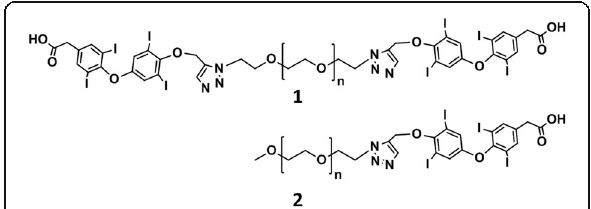
Fig. 1 Chemical structures of P-bi-TAT ( 1 ) and P-mono-TAT ( 2 ); and n means the average number of repeating oxyethylene units